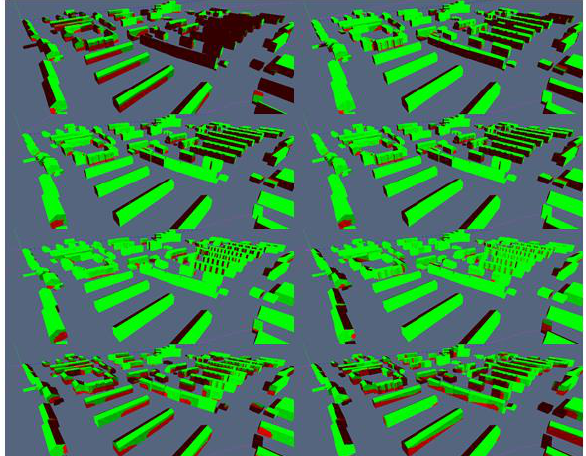
Figure 7 Hourly differences in Sky View Factor for Direct Radiation on a specific day